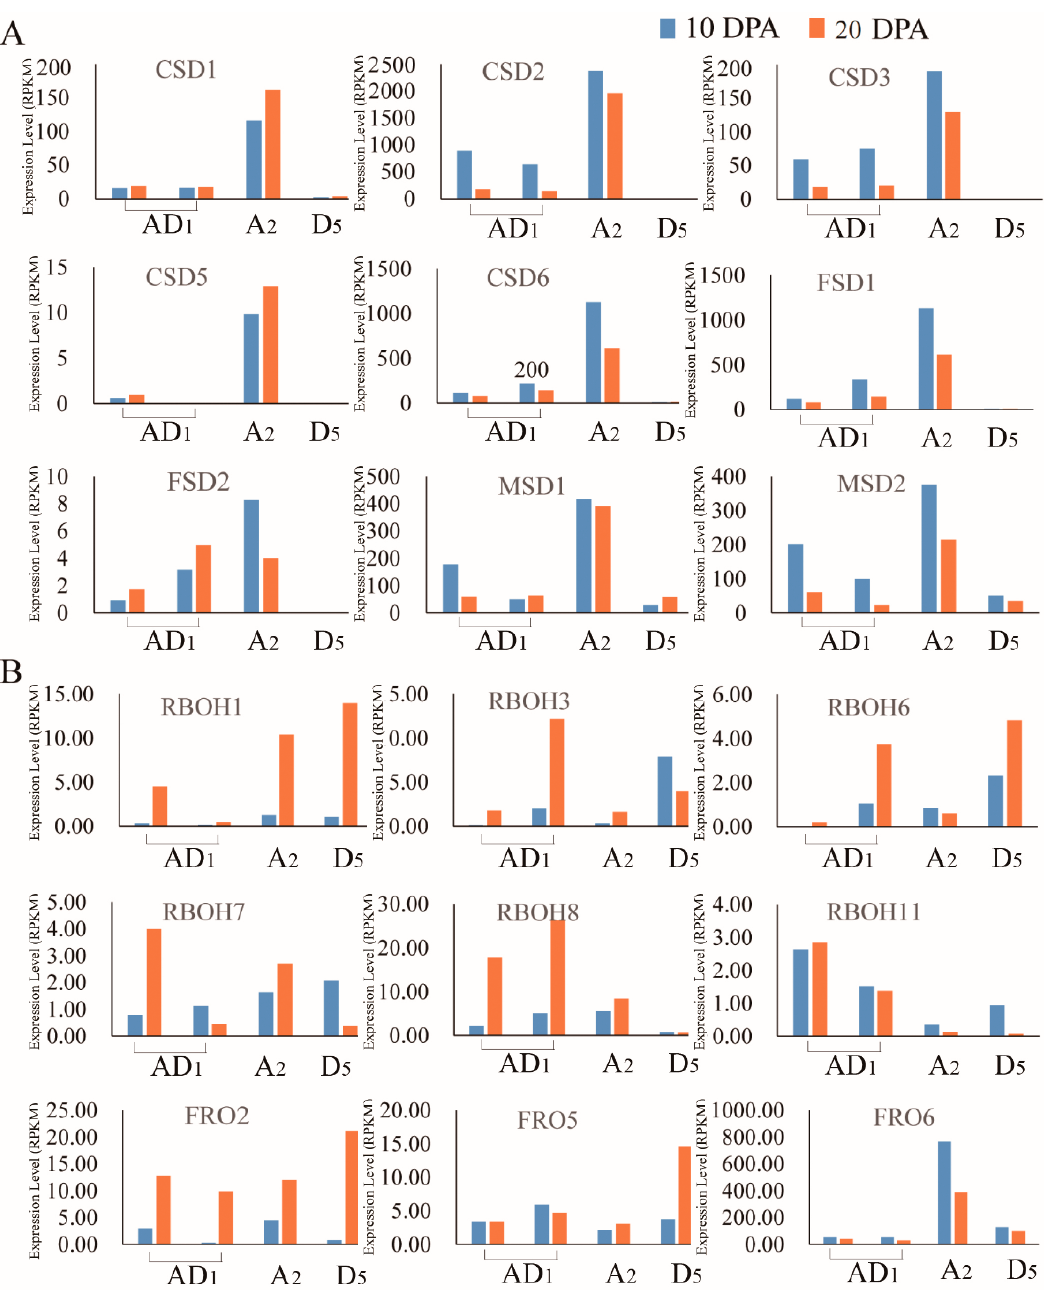
Figure 4. Expression level obtains from RNA-seq data and was show with RPKM (Reads per Kilobase of exon model per Million mapped reads). ( A ) The expression level of superoxide dismutase (SOD) genes family. ( B ) The expression of respiratory burst oxidase homologue (RBOH)and NADPH-like oxidase (FRO).